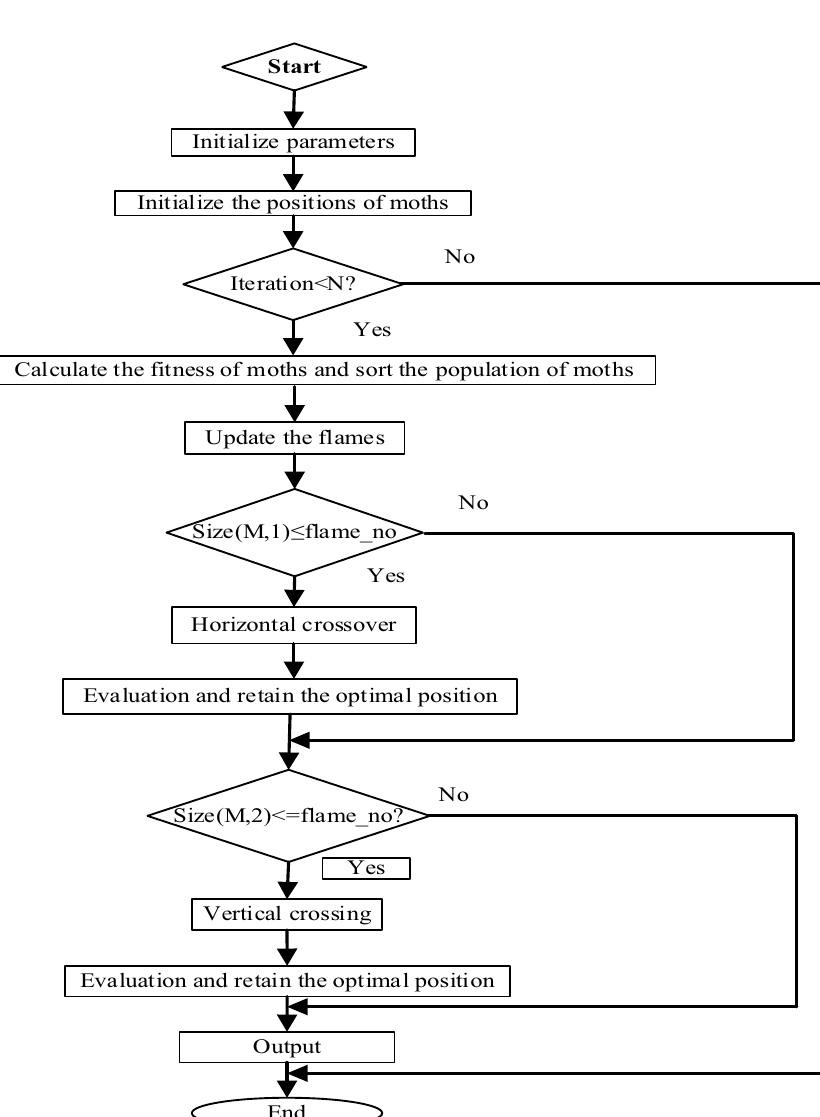
Fig. 2 Flowchart of the proposed IMFO